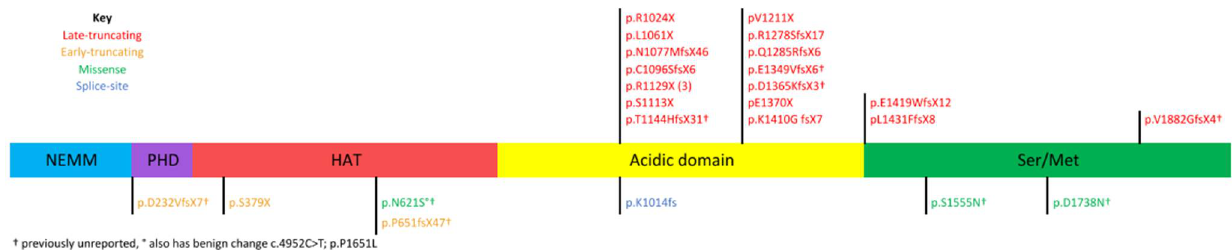
Figure 1. KAT6A domains and distribution of participants’ variants. NEMM, N-terminal part of Enok, MOZ, or MORF; PHD, plant homeodomain; HAT, histone acetyltransferase; Ser/Met, serine/methionine-rich region.